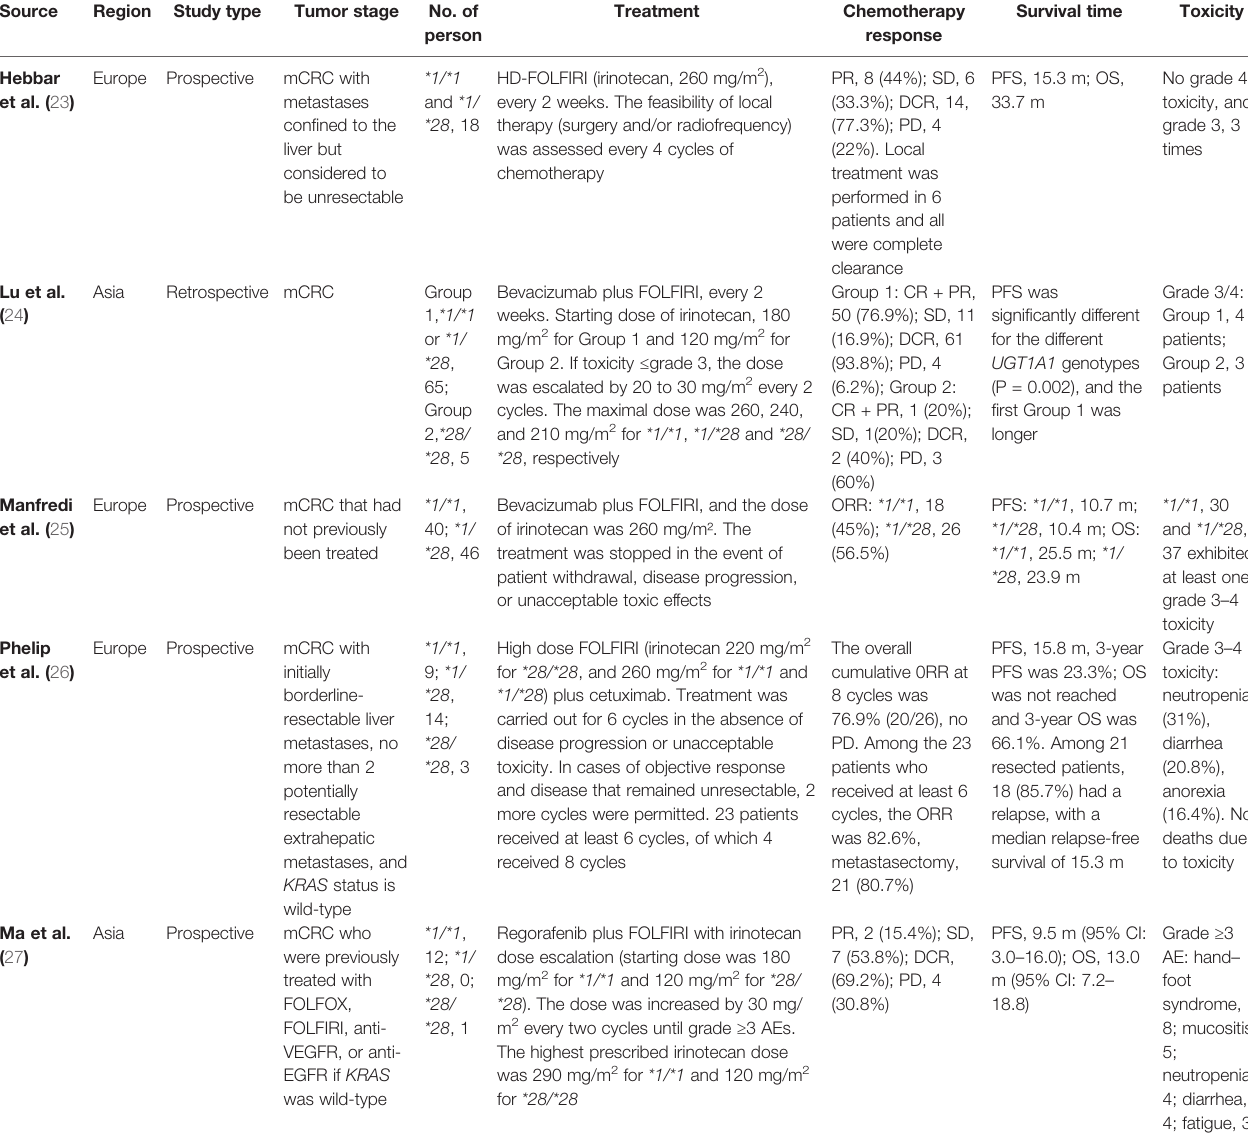
TABLE 2 | Single-arm Trials of High dose Irinotecan based Regimen in